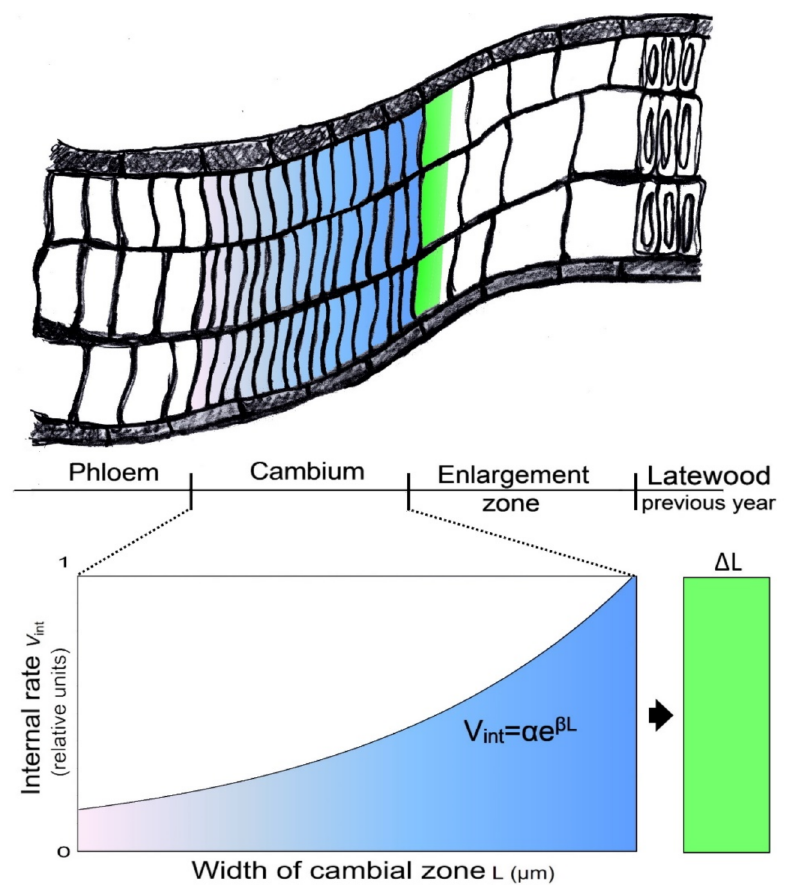
Figure 2. Conceptual description of a new model block: cambium zone consisting of several adjacent rows of cambial cells (gradient blue color–faster growth in this case associated with the more saturated color), and the enlargement zone with an increment ∆ L per unit time (green color) (Upper panel); width of cambial zone (gradient blue color) increased by ∆ L (green color) with an exponential rate V int , which characterizes the individual growth rate of the woody tissue (Low